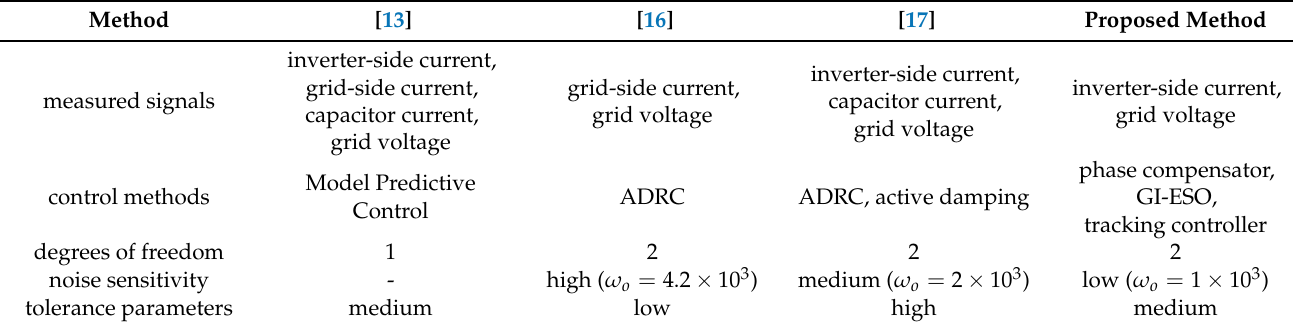
Table 2. Comparison of this method with related